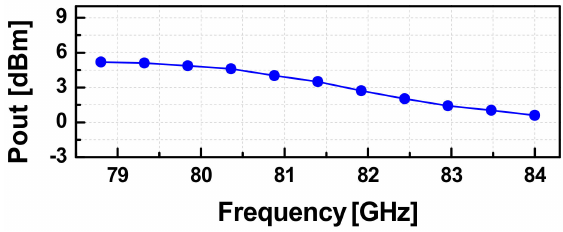
Figure 19. The measured output power of the PLL versus frequency.